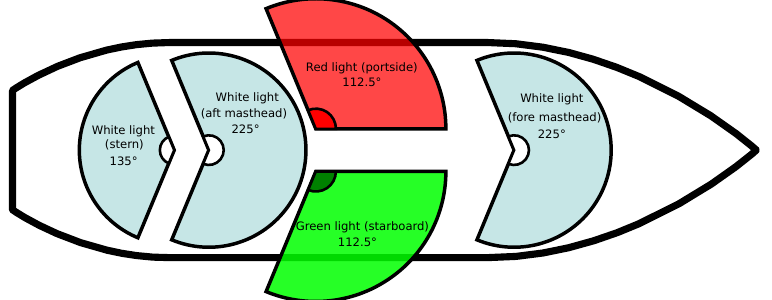
Figure 3. A ship’s navigation lights as prescribed by COLREG.